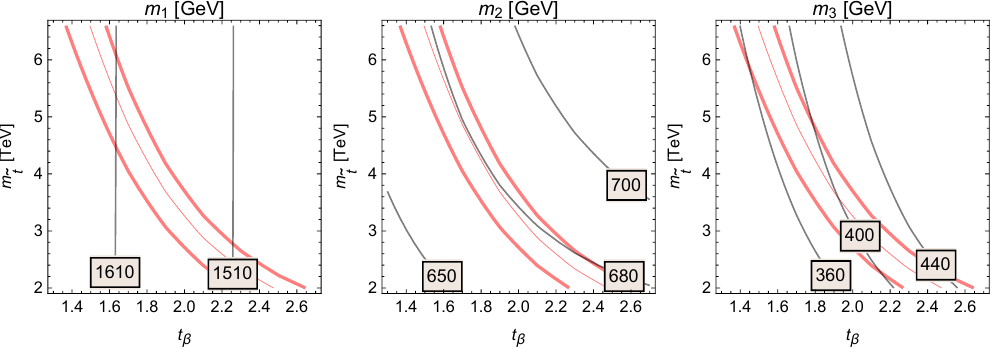
Figure 8 . The mass spectrum of the scalars for the numerical benchmark illustrated for the F - term model in this section. m 1 and m 3 are dominantly from the scalars on the H side and m 2 is dominantly from the h b side. The red band indicates the Higgs mass window (122 GeV, 128 GeV). The scale F increases slightly with (cid:22) (cid:21) and is around 1.3 TeV everywhere.